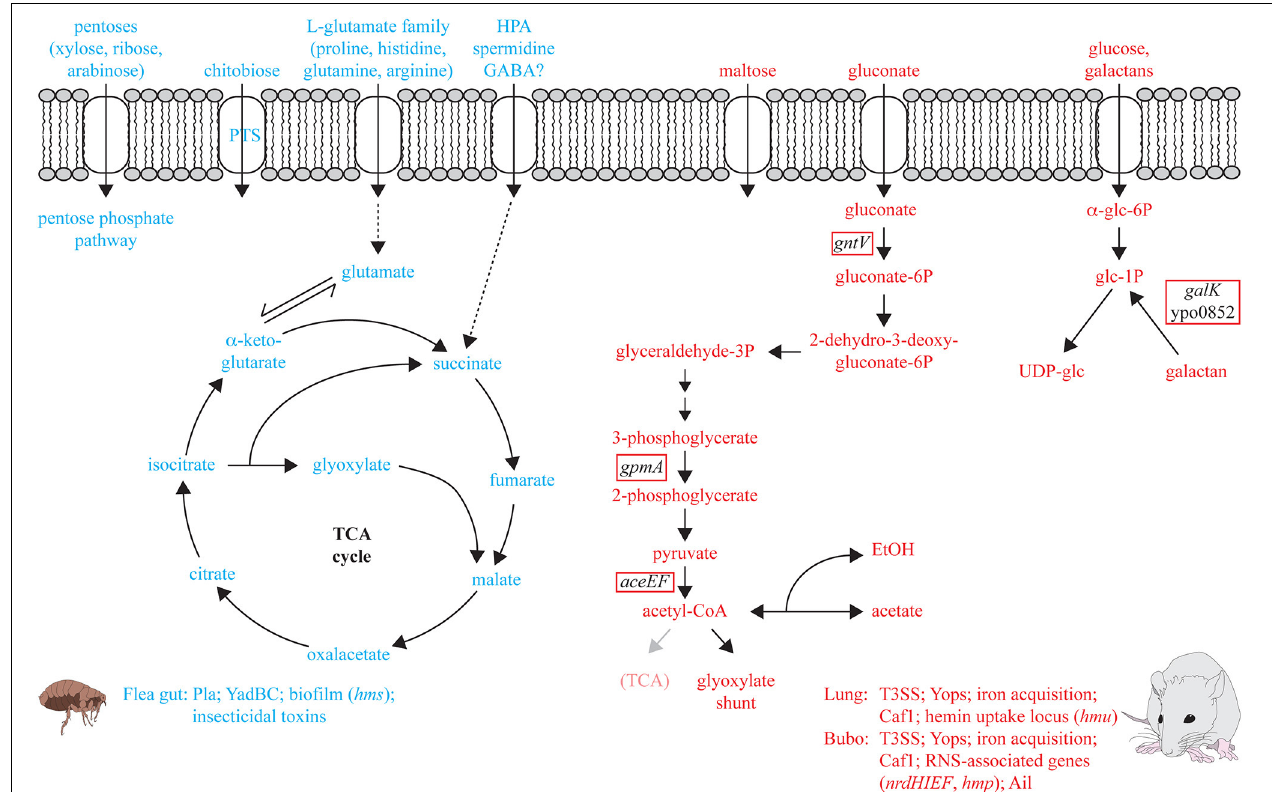
FIGURE 2 | Metabolic pathways and virulence factors of Y. pestis induced in the flea and the mammalian host. Metabolic functions and pathogenicity traits upregulated in vivo are illustrated which are considered to